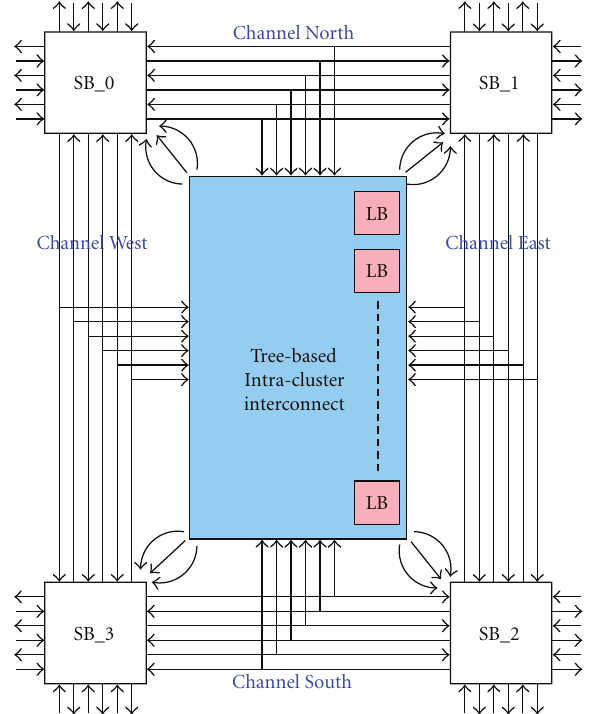
Figure 18: Node of Mesh of Tree